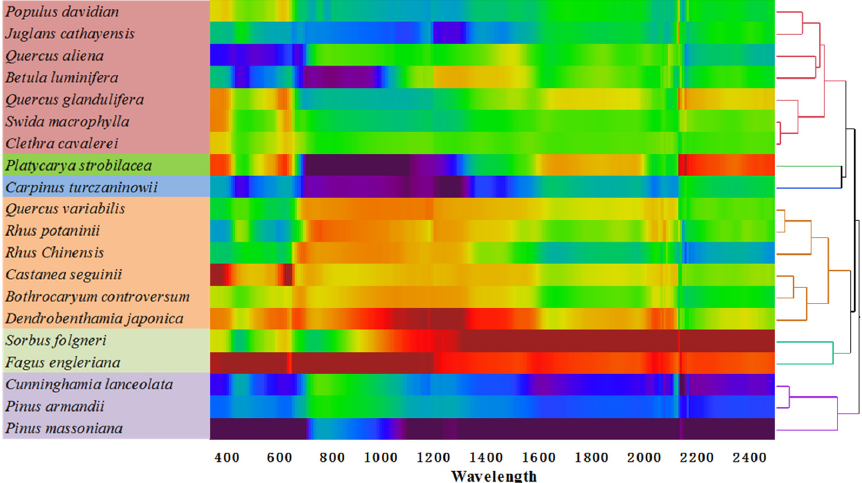
Figure 4. Hierarchical cluster analysis of 20 dominant species based on their spectral reflectance signatures from 400 to 2400